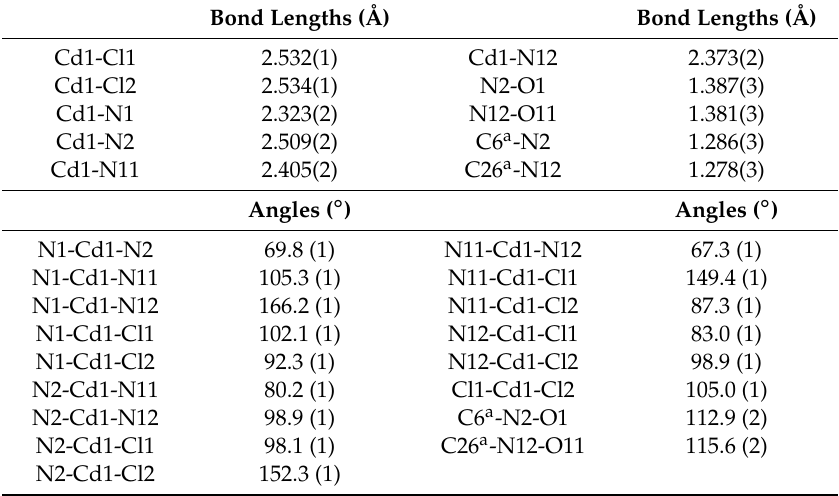
Figure 6. Formation of layers parallel to the (001) plane through π - π stacking interactions (dashed dark green lines) in the crystal structure of 2 . The C-H ··· π interactions are not shown for clarity reasons. The color code for the hydrogen bonds is the same as used in Figure 5. Table 2. Selected bond lengths (Å) and angles ( ◦ ) for complex[CdCl 2 (phpaoH) 2 ] · H 2 O ( 1 · H 2